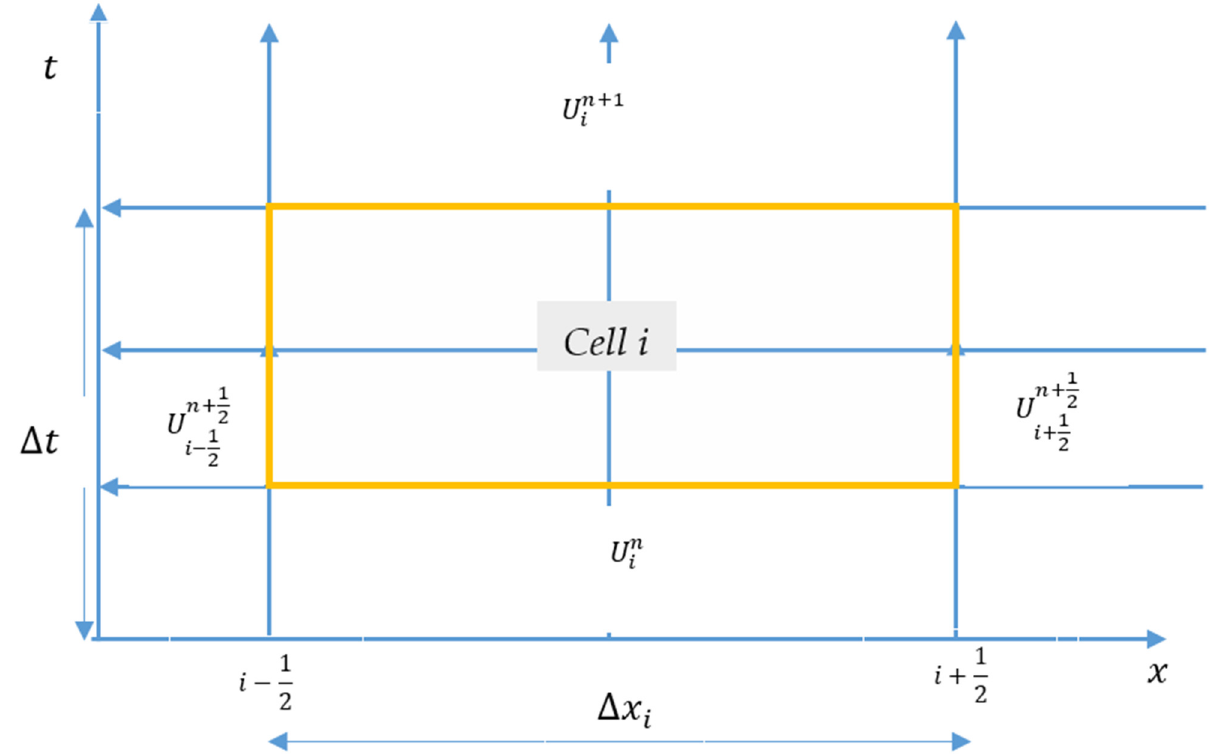
Figure 4. Discretization of the domain in the finite volume method [9].